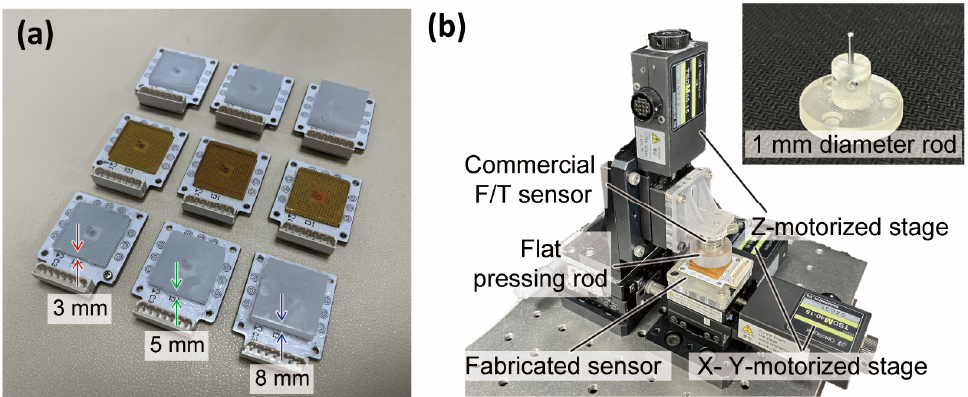
Figure 2. ( a ) Single BPSC-based sensors with different soft materials. (row) Different material types. (column) Different thicknesses. ( b ) Experimental bench for fundamental characterization with three motorized stages, reference sensor, and two types of rods.